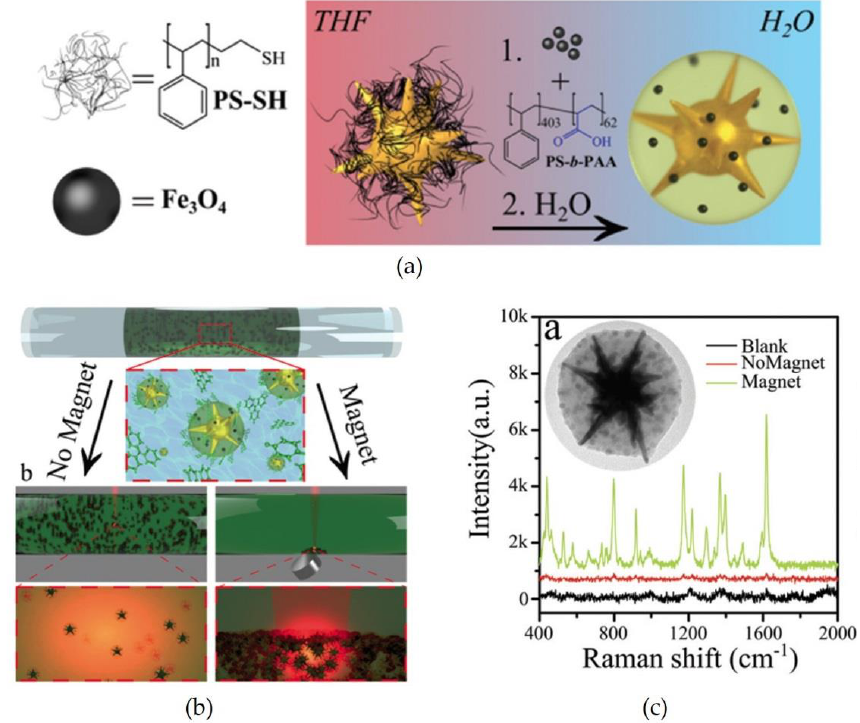
Figure 8. ( a ) Schemes of the preparation for Au nanostars coated with polymer shells consisting of magnetic NPs; ( b ) the assembly of the particles near a magnet; and ( c ) Raman spectra of probe molecules (Marachita Green) measured with the magnetic field. Reproduced with permission from